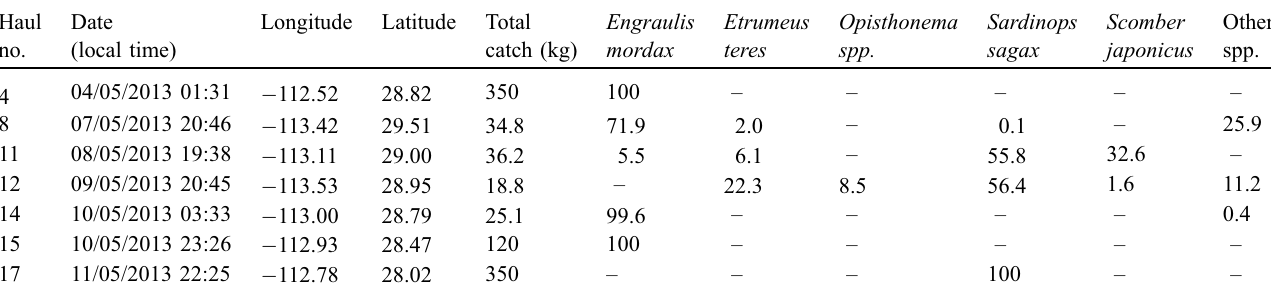
Table 1. Catch composition (%), date and geographic location of the selected fi shing hauls for which associated echograms were analysed. The category “ Other spp. ” includes fi sh species from families Triglidae, Carangidae, Ariidae, Scombridae and Myctophidae, among others, occasionally present in the